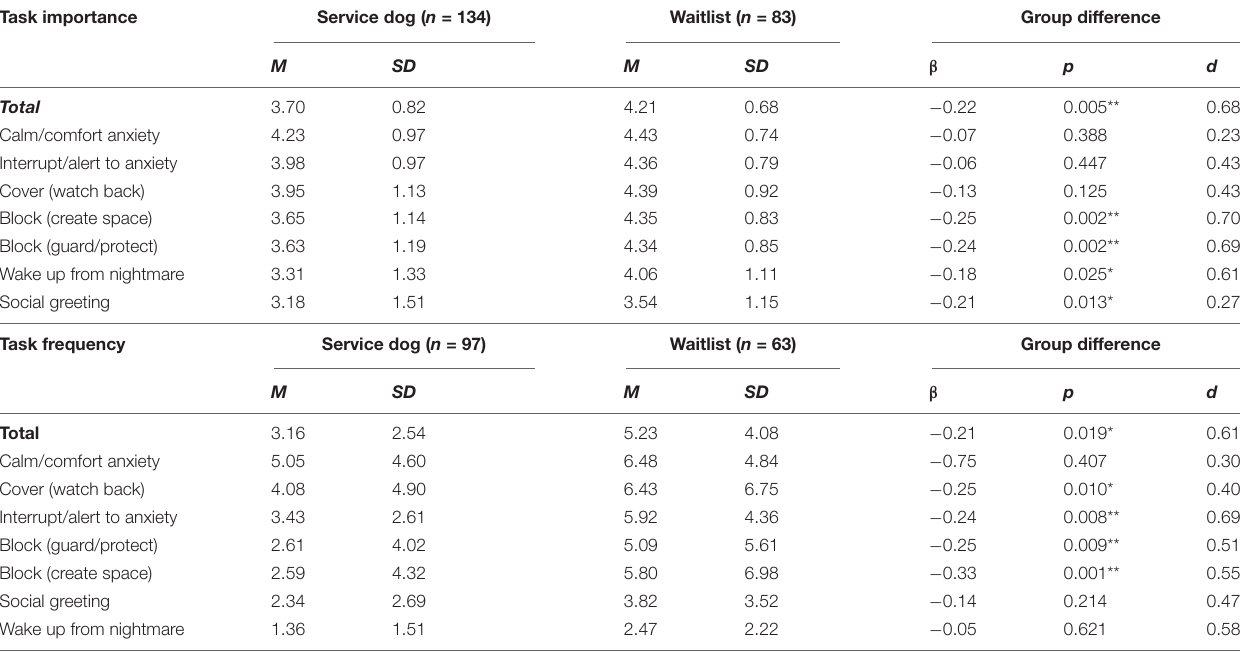
TABLE 2 | Means, standard deviations and group comparisons of the expected and experienced importance of trained tasks for PTSD symptoms (1 = Not at all important to 5 = Extremely important) and frequency of trained task use per day. Task importance